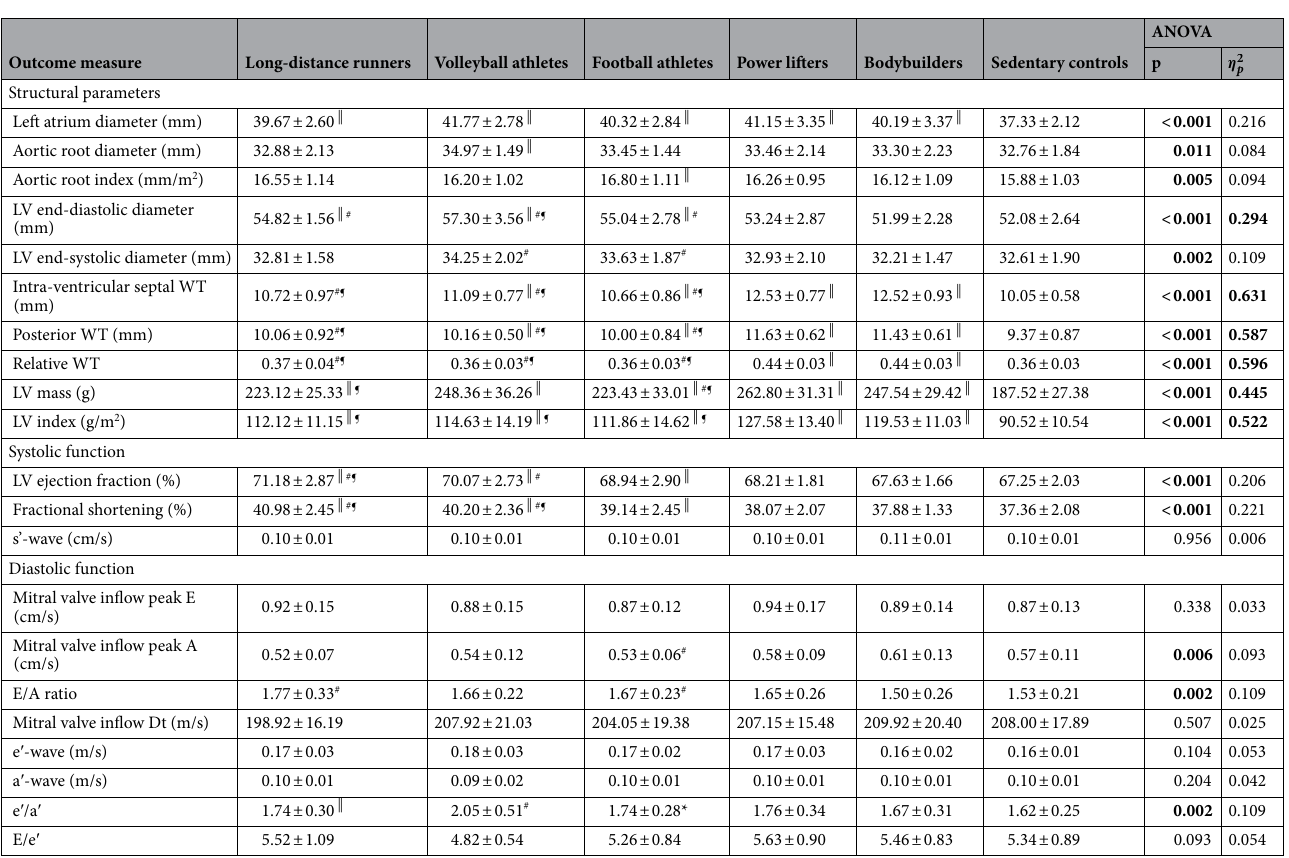
Table 3. Echocardiographic parameters (mean ± standard deviation) in long-distance runners (n = 12), volleyball athletes (n = 14), football athletes (n = 39), powerlifters (n = 26), bodybuilders (n = 39), and sedentary controls (n = 43). Relative wall thickness = (2 × posterior wall thickness)/LV end-diastolic diameter; bolded p 2 values indicate statistically significant difference (p < 0.05), bolded η p indicate moderate to strong effects. LV left ventricular, WT wall thickness, Dt deceleration time, s’-wave systolic mitral annulus velocity (average of septal and lateral measurements), e’-wave early diastolic myocardial relaxation (average of septal and lateral measurements), a’-wave active atrial contraction in late diastole (average of septal and lateral measurements). *ssignificantly different from volleyball athletes. # Significantly different from bodybuilders. ¶ Significantly different from powerlifters. ║ Significantly different from sedentary